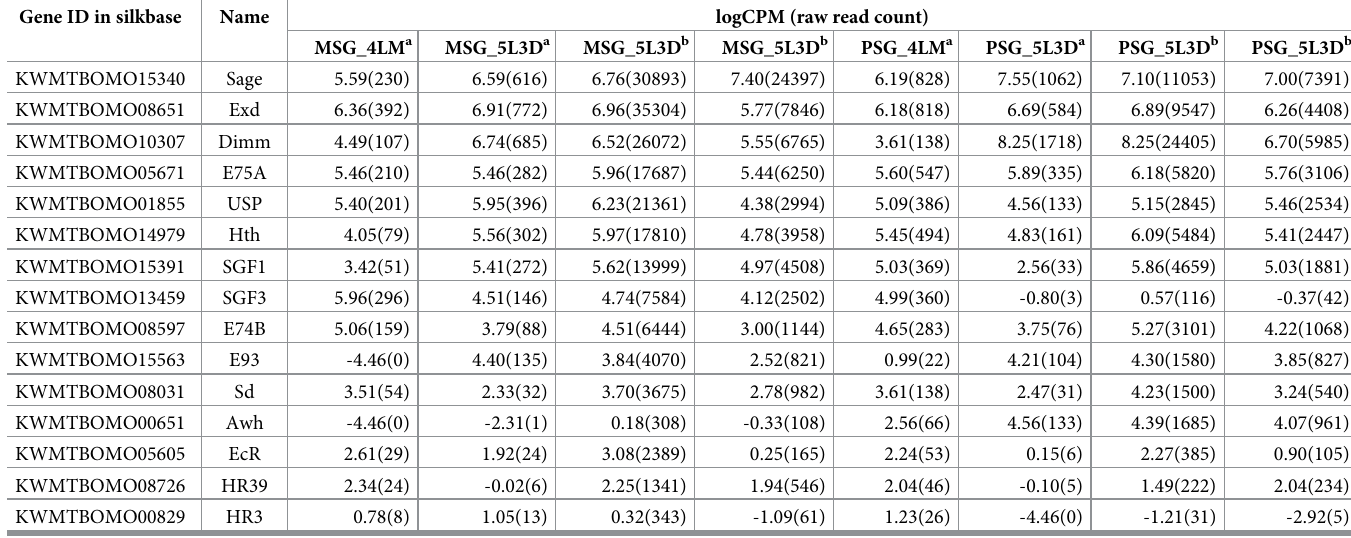
Table 1. Expression data of 15 representative TFs expressed in the SG. Gene ID in silkbase